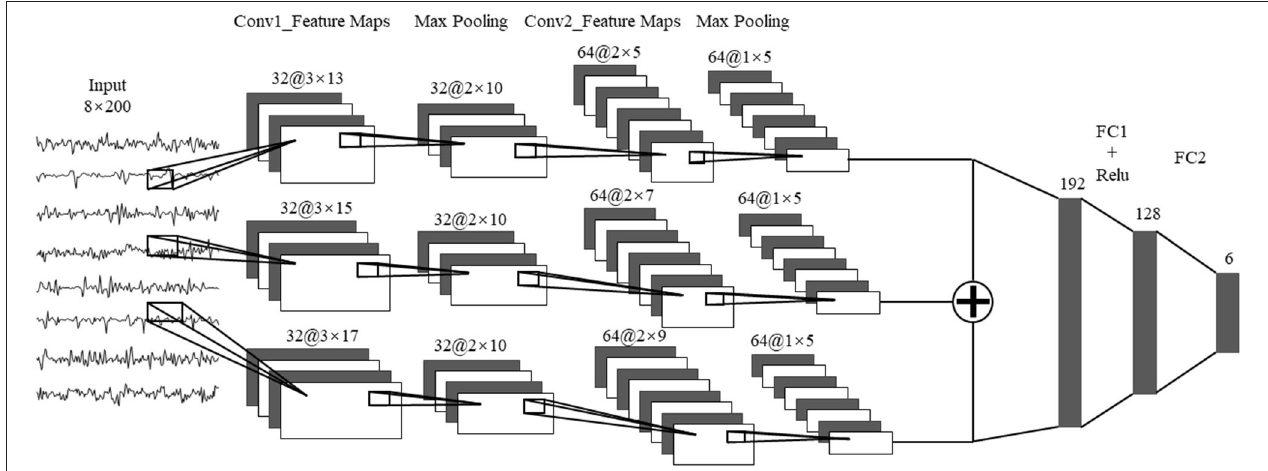
FIGURE 5 | The multi-channel CNN algorithm. Conv1, convolution layer 1; Conv2, convolution Layer 2; FC1, fully connected layer 1; FC2, fully connected layer 2.